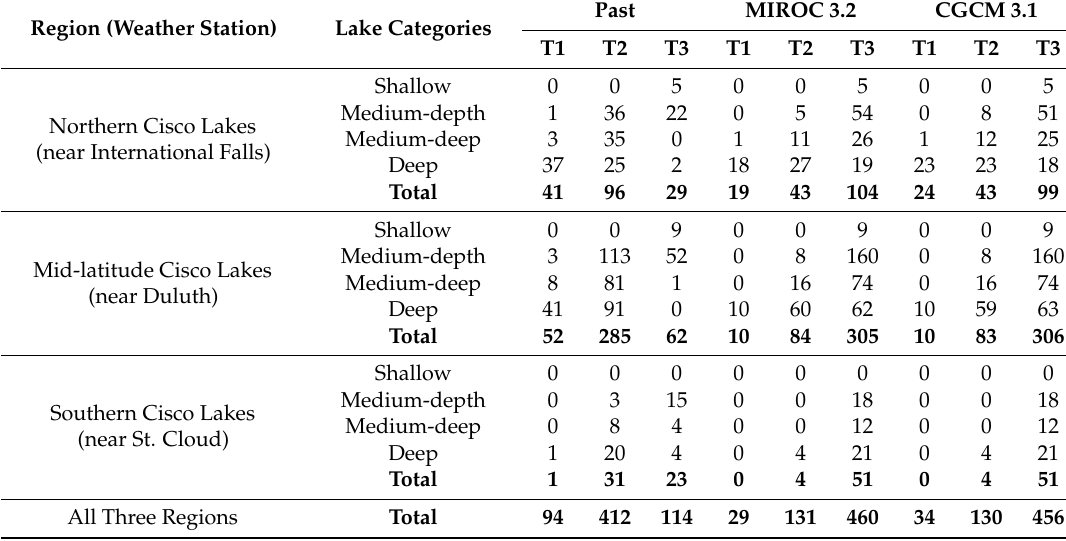
Table 8. Number of lakes selected as Tier 1 (T1) and Tier 2 (T2) refuge lakes and Tier 3 (T3) non-refuge lakes from the 620 cisco lakes grouped by maximum depth and latitude when the contour lines of AvgATDO3 VB simulated from the 30 deep virtual lakes were